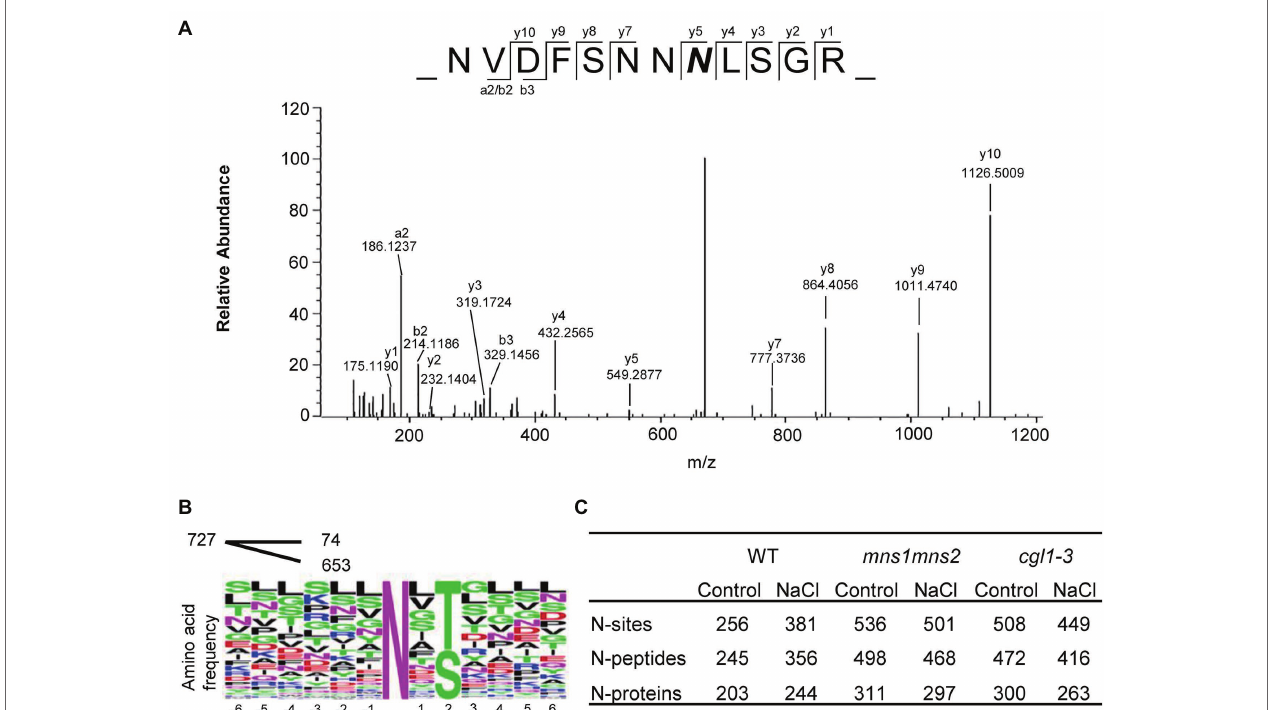
FIGURE 2 | An overview of identified N-glycosylated motifs, peptides, and proteins. (A) Representative MS/MS spectrum of the peptide NVDFSNNNLSGR of the EF-Tu receptor (EFR). The 2.9890 Da mass increment of deamidation is indicated by a bold italic N . (B) Consensus sequence of identified N-glycosylation sites. Multiple glycosylated sequence motifs were analyzed, and relative frequency plots are shown. Of the total 727 sequence motifs, 74 are noncanonical motifs with an occurrence of <20 each. (C) Statistics of identified N-glycosites, N-glycopeptides, and N-glycoproteins by three replicates in six sample